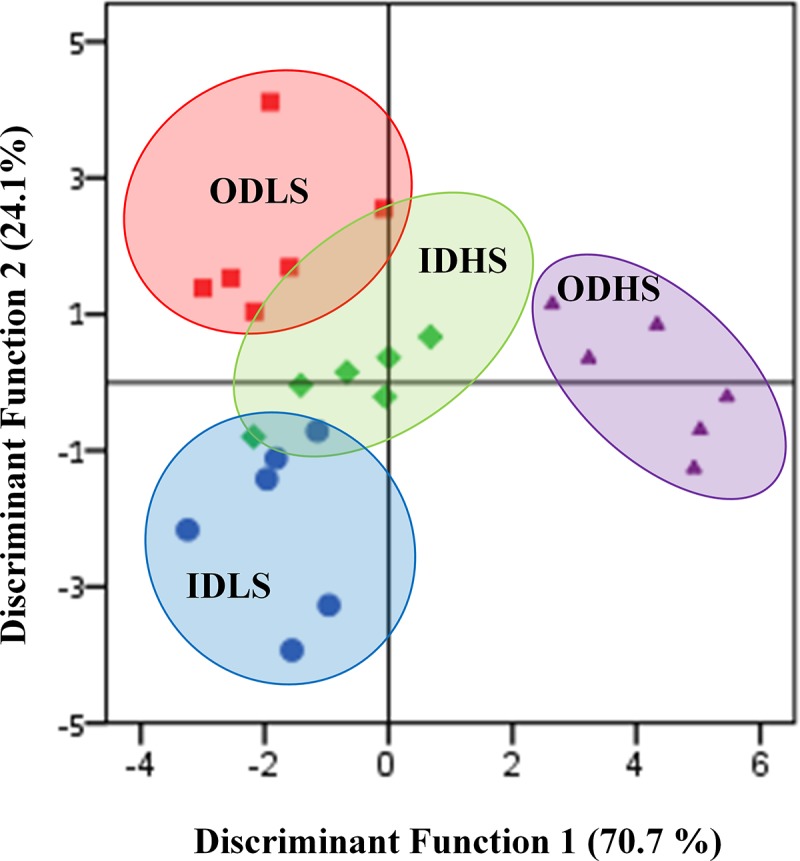
Score plot from a discriminant analysis.Each subject is represented according the score obtained for discriminant functions 1 and 2. The colour of these points and of the grouped oval indicates the experimental groups (IDLS, IDHS, ODLS and ODHS).